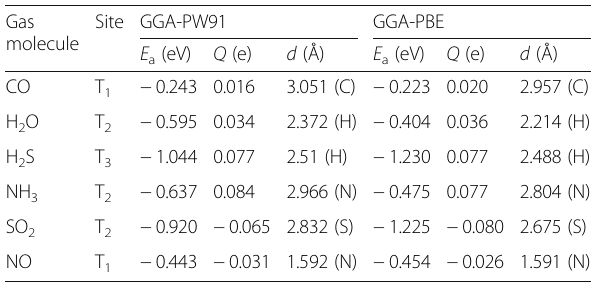
Table 2 Results for gas molecules on PG calculated by PW91 and PBE functionals